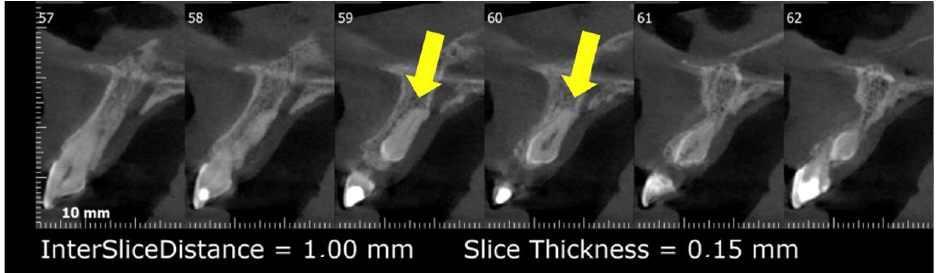
Figure 4. Maxillary cone-beam computed tomography (CBCT). Sagittal slice image. Located in the inter-radicular area of teeth 1.1 – 2.1. Mesiodens with the dilacerated apex towards the palate, impacted the cortical bone of the nasopalatine canal, with slight compromise of the cortical bone. Yellow arrows — location of mesiodens